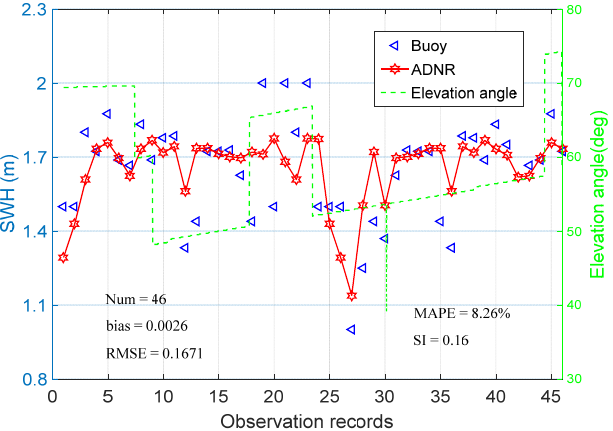
Figure 6. Retrieval results of the proposed algorithm. The gap between two observations is 30 min.